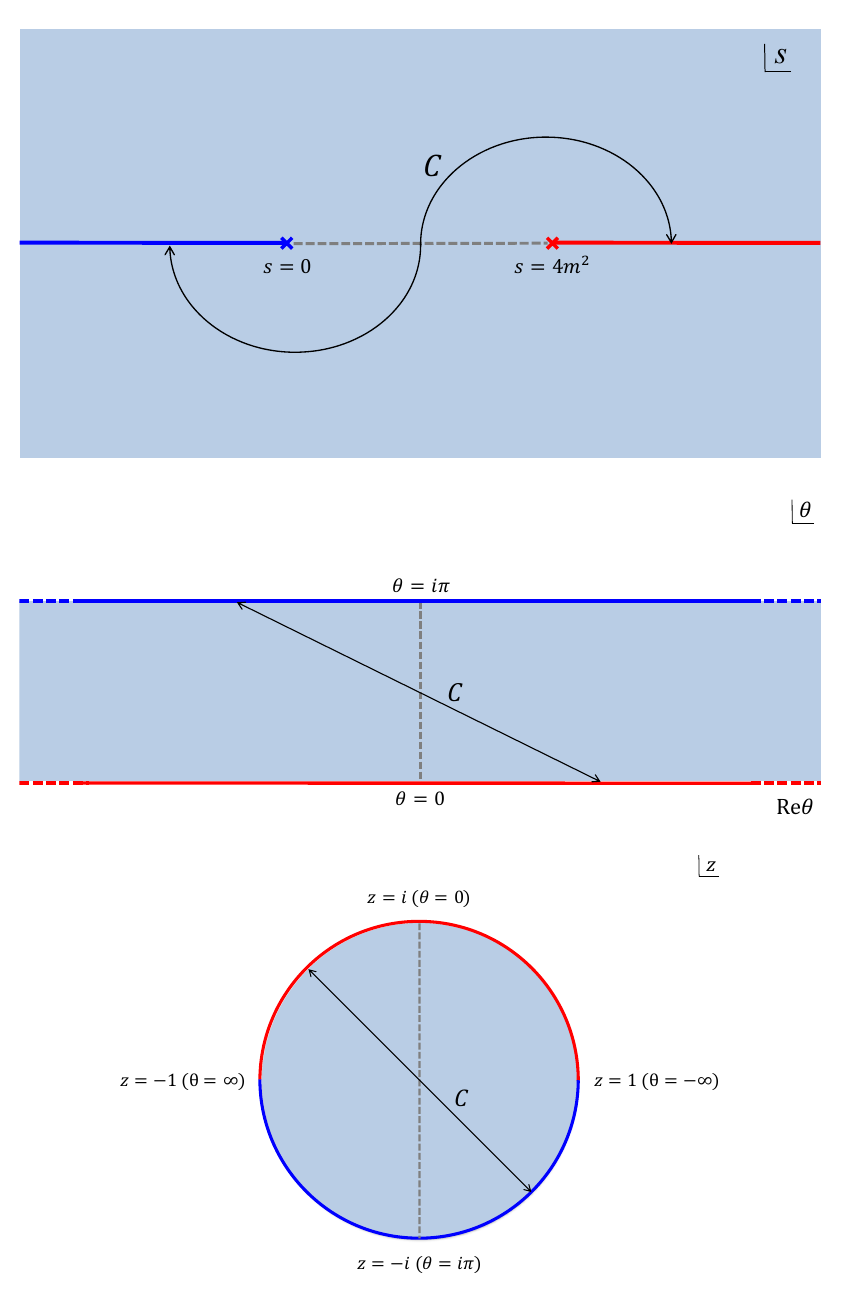
Figure 1. Di(cid:11)erent variables used to write the S -matrices. The (cid:12)rst one s is the usual Mandelstam variable and the other two are de(cid:12)ned in eq. (1.6).